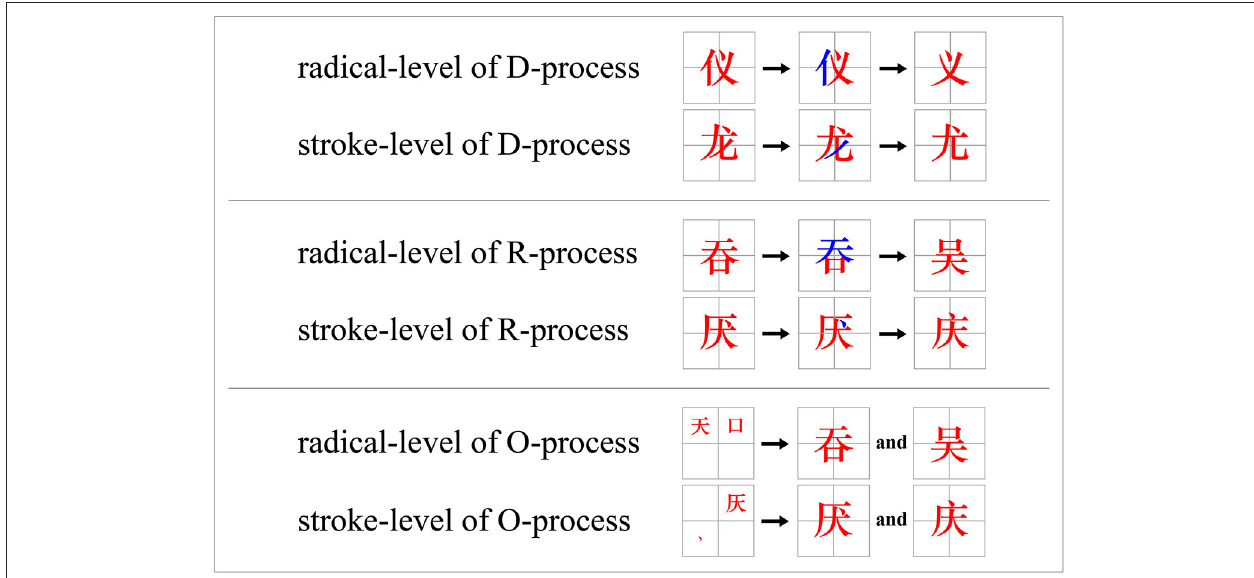
FIGURE 1 | Examples of D-, R-, and O-process tasks. For the example of the radical level of the D-process, the initial state (task) was “ 仪 ” and the goal state (solution) was “ 义 ”; for the example of the stroke level of the D-process, the initial state was “ 龙 ” and the goal state was “ 尤 ”; for the radical level of the R-process, the initial state was “ 吞 ” and the goal state was “ 吴 ”; for the stroke level of the R-process, the initial state was “ 厌 ” and the goal state was “ 庆 ”; for the example of the radical level of the O-process, the initial state was “ ” and the goal state was “ 吞 ” and “ 吴 ” or “ 吴 ” and 吞 ”; for the example of the stroke level of the O-process, the initial state was “ ” and the goal state was “ 厌 ” and “ 庆 ” or “ 庆 ” and “ 厌 .” The color was only for illustration, and that the characters appeared in black in the